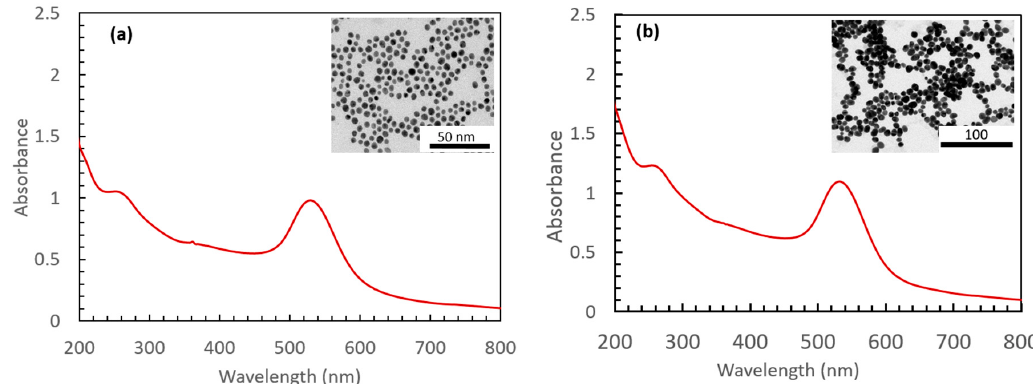
Figure 1. UV-Visible spectra and inset TEM images of the spherical gold nanoparticles synthesized by citrate reduction: ( a ) 15 nm-gold nanoparticles (AuNPs)@citrate and ( b ) 30 nm-AuNPs@citrate. Optical path length: 1 cm.